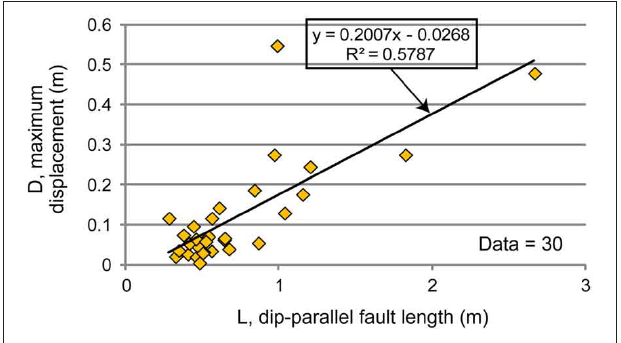
FIGURE 9 | Fault maximum displacement (D) vs. dip-parallel length (L) diagrams for the Cingoli faults. The black line is the linear best fit.